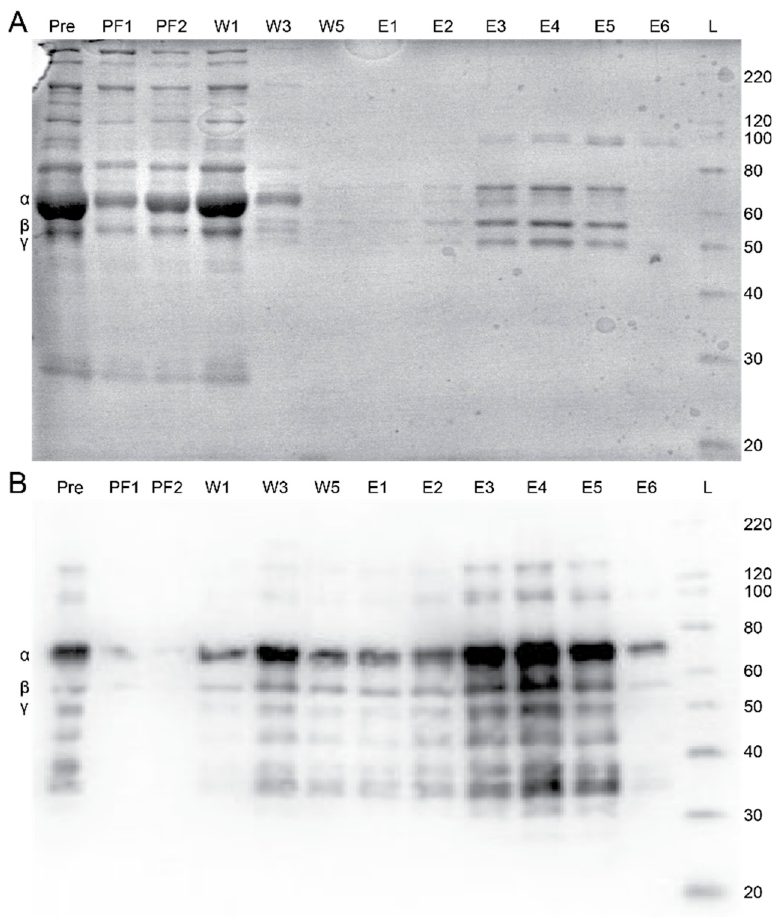
Figure 4. Selective purification of human fibrinogen from fresh frozen plasma with the GPRPFPAWK affinity column. ( A ) Coomassie and ( B ) Western blot images showing plasma proteins before and after running over the GPRPFPAWK affinity column, with similar eluting steps discussed above. The Coomassie gel shows high selectivity for fibrinogen in the elutions.